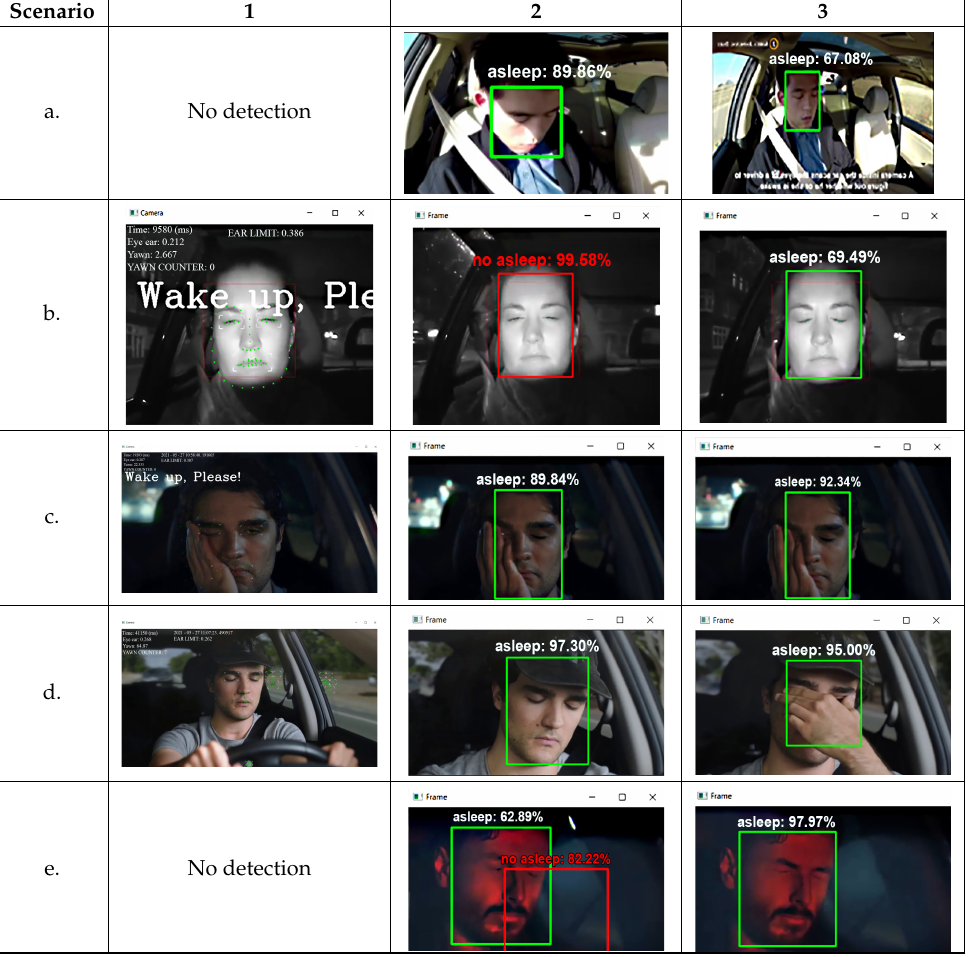
Table 7. Illustration of drowsiness detection and prediction on videos for three